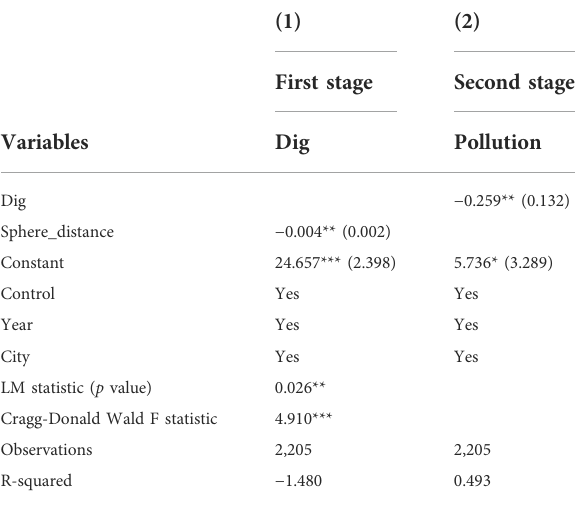
TABLE 7 Estimates of instrumental